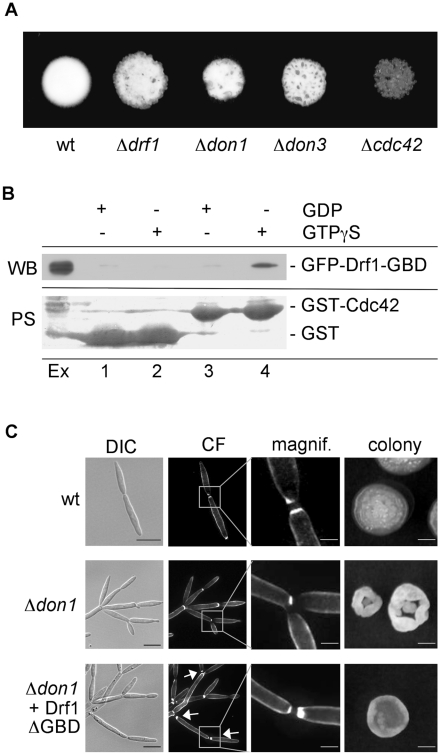
Drf1 is an effector of Cdc42.A: Compatible mixtures of the indicated haploid strains were spotted on charcoal-containing medium. Plates were incubated for two days. B: Pull-down experiment of GFP-Drf1-GBD: GST (lanes 1 and 2) or GST-Cdc42 (lanes 3 and 4) loaded with GDP (lanes 1 and 3) or GTPgS (lanes 2 and 4) were loaded with U. maydis protein extract containing GFP-Drf1-GBD (Ex). After pull-down immunoblotting (WB) was performed with anti-GFP antibody. Blots were stained with PoinceauS (PS) as loading control. GTP-bound Cdc42 could interact with the GBD of Drf1. C: Constitutive active Drf1ΔGBD was able to partially suppress the don1 deletion phenotype. Wt, Δdon1 and Δdon1+pETEF-Drf1ΔGBD were stained with calcofluor white (CF) (central columns). Arrows indicate secondary septum formation. For the colony morphology images (right column) single cells were grown for three days on YEPS with 1.3% Agar. (Scale bars: 10 µm for the left column, 2 µm for the magnifications and 1 mm for the colonies).